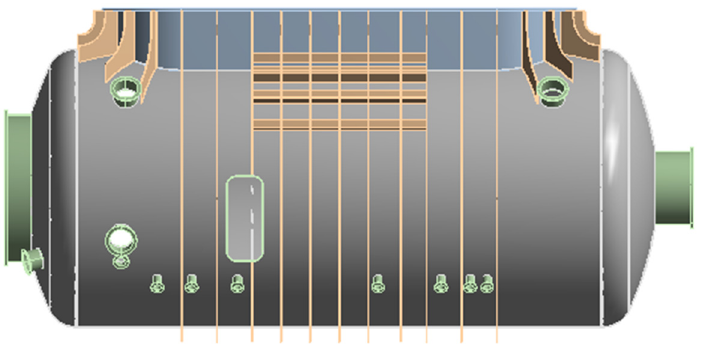
Figure 13. Illustration of the test cabin reinforced with longitudinal and transverse ribs.